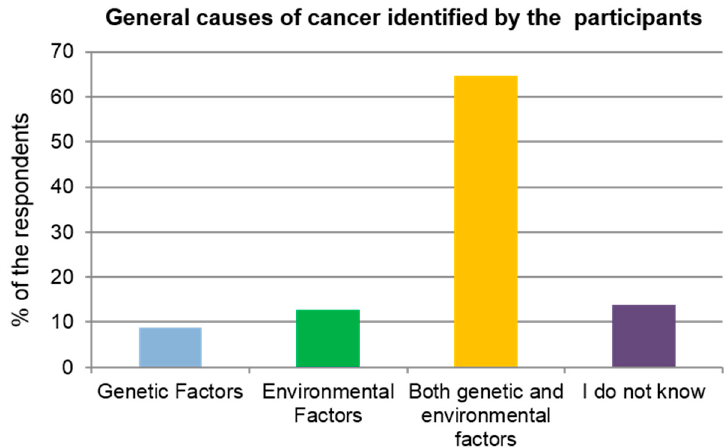
Figure 1. General causes of cancer identified by the study population.